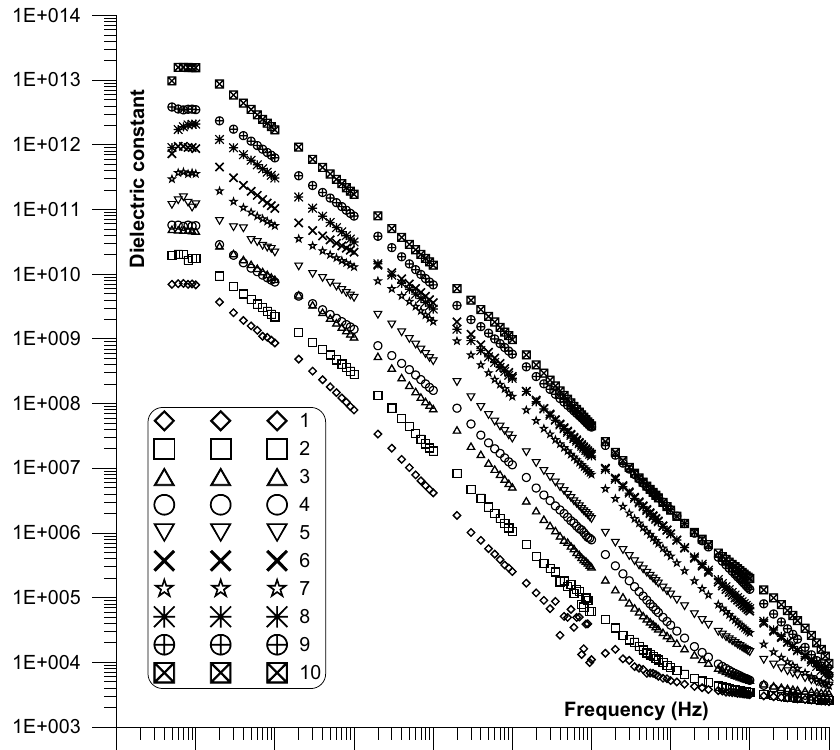
Fig. 1 Change in dielectric constant with frequency at different saturation levels of saline water (4 g/100 g of NaCl) [(1) diamond, (2) square, (3) triangle, (4) circle, (5) inverted triangle, (6) times symbol, (7) star symbol, (8) asterisk, (9) oplus symbol, (10) open square with times